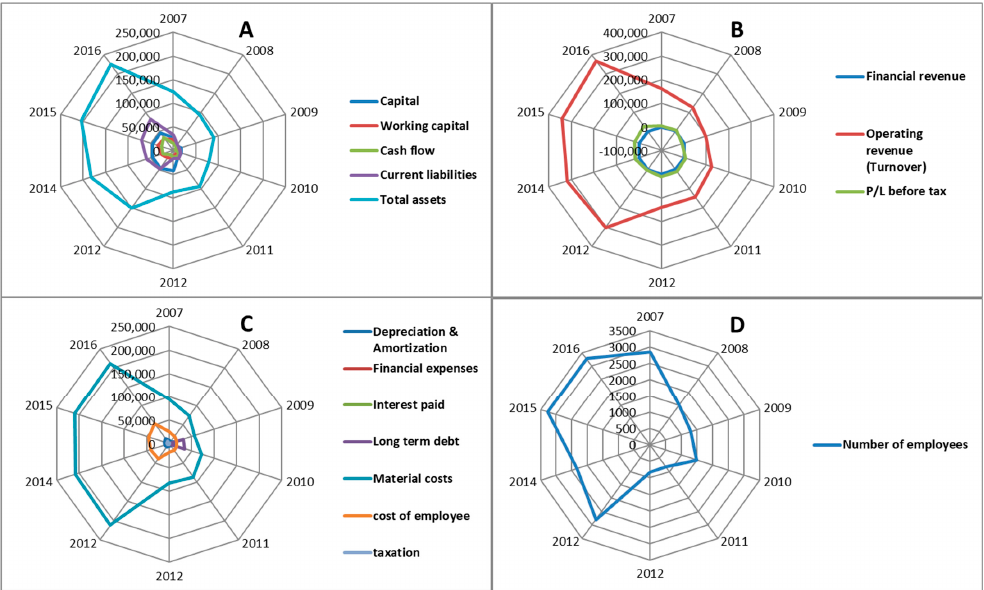
Figure A1. Historical financial results of the companies: Input segment of the coal value chain. ( A )—financial performance; ( B )—result of the activity; ( C )—costs; ( D )—employment.